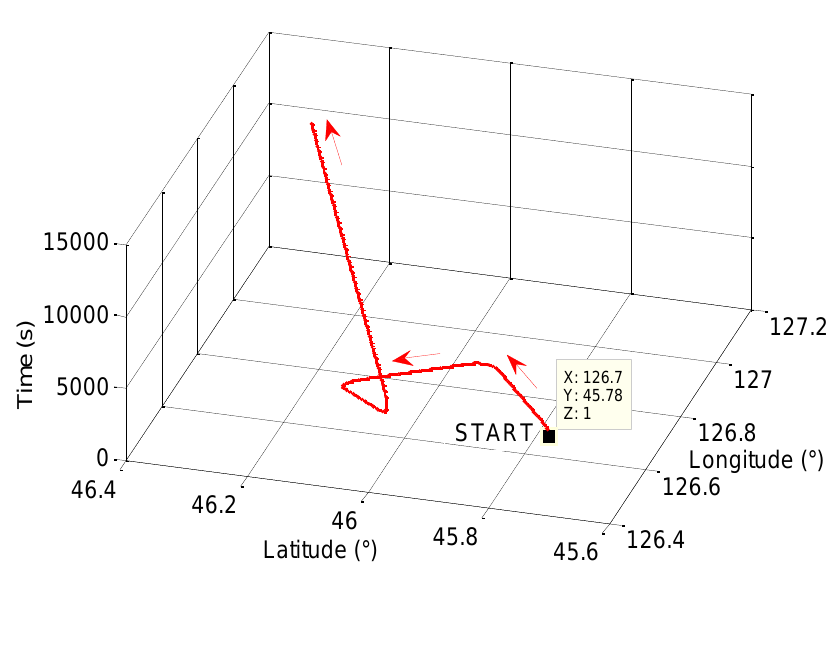
Figure 4. Sailing track of the marine